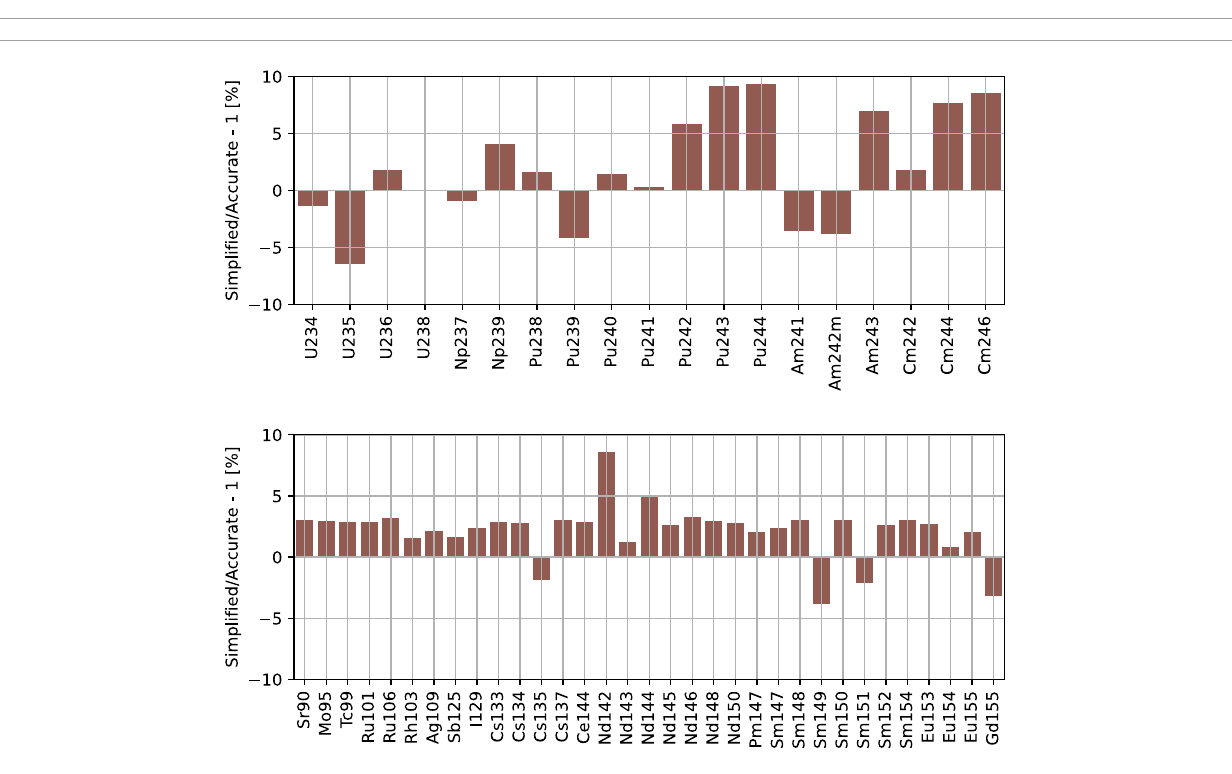
FIGURE 3 Deviations (in percent) on nuclide concentrations (also called C/C-1) introduced by the Serpent model simplifications. The ratio denominators are the results of the accurate model.